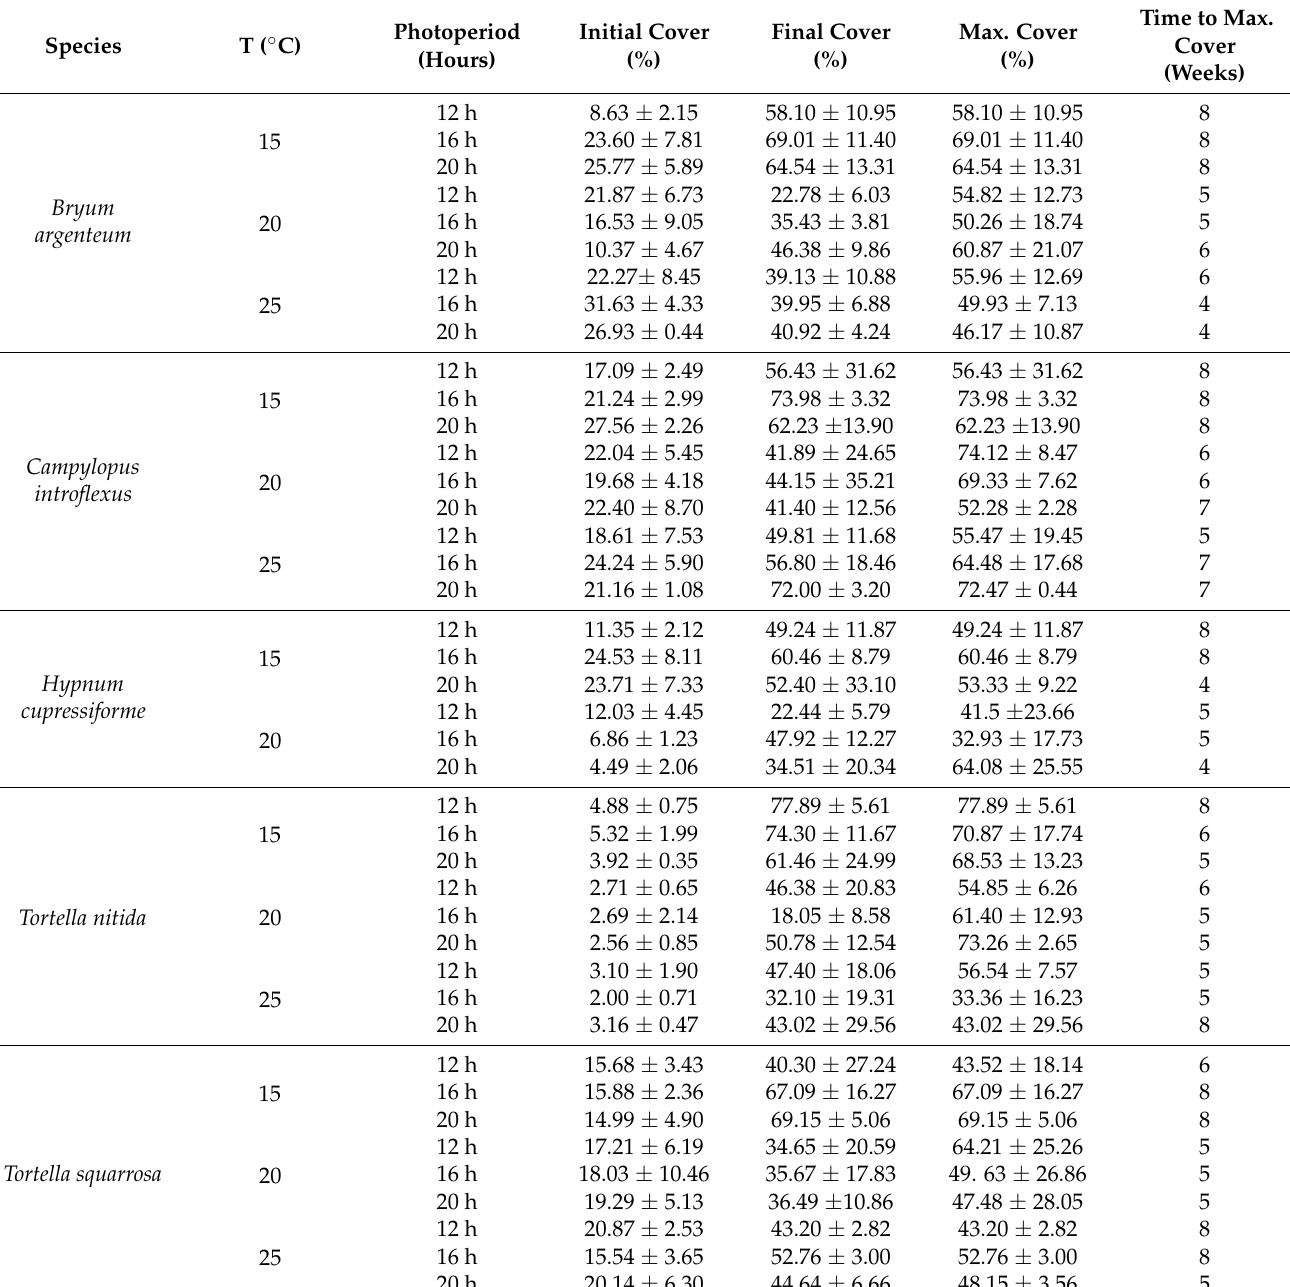
Table 1. Mean of the initial, final, and maximum coverage (%) and the standard deviation of the different moss species for the different variables and time (weeks) to cover